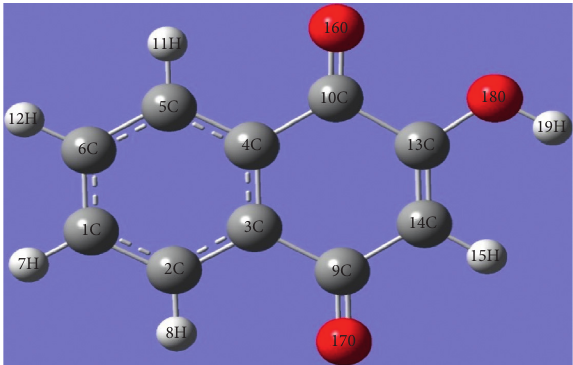
Figure 22: The optimized molecular structure of lawsone.